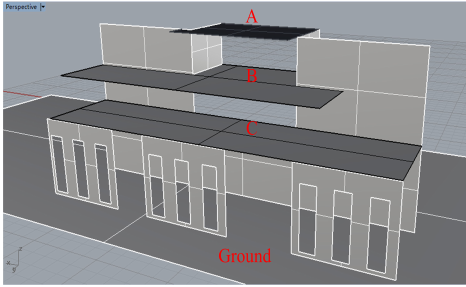
Figure 11. Identified experimental components for top-bounded space creation.